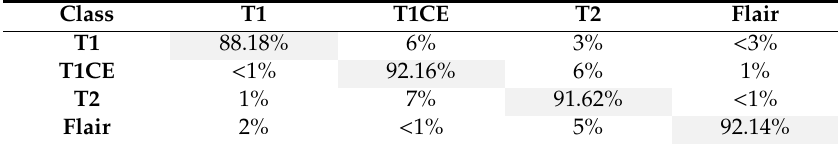
Table 9. Confusion matrix of ELM using the Pro-FC7 approach for the BraTS 2017 dataset.